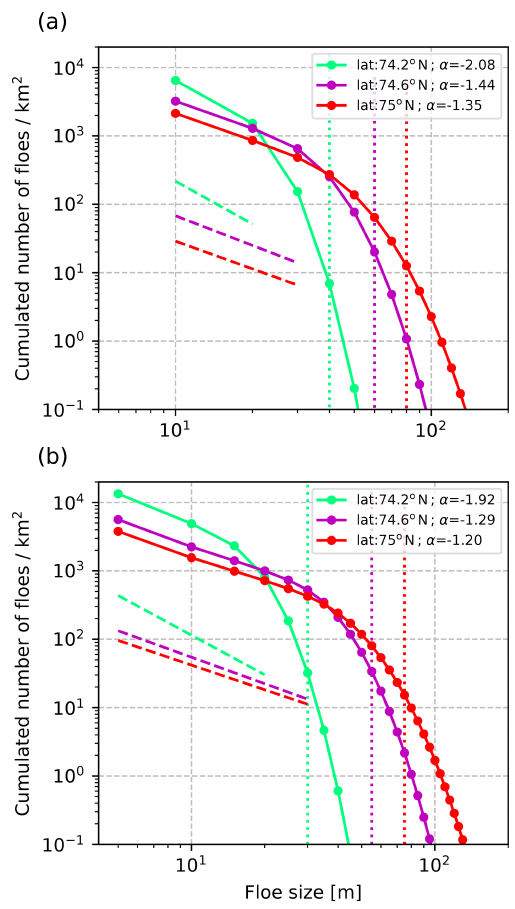
Figure 4. Cumulative distribution of floes taken at three differ- ent locations from the NXM/WW3 simulation (a) and from the NXM/WW3_refine simulation (b) . The three locations share the same longitude (150 ◦ W), and their position is indicated by a sym- bol of the same colour in Fig. 3a and b (red colour corresponds to the AWAC position). The dashed lines correspond to the linear regression over the smallest floe size categories for each location. Values of the slope are given in the legend. The vertical dotted lines represent the D max values for each